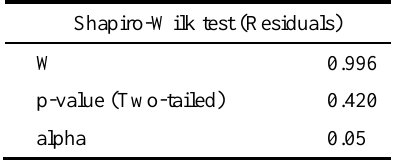
Table 6. Shapiro-Wilk Test results